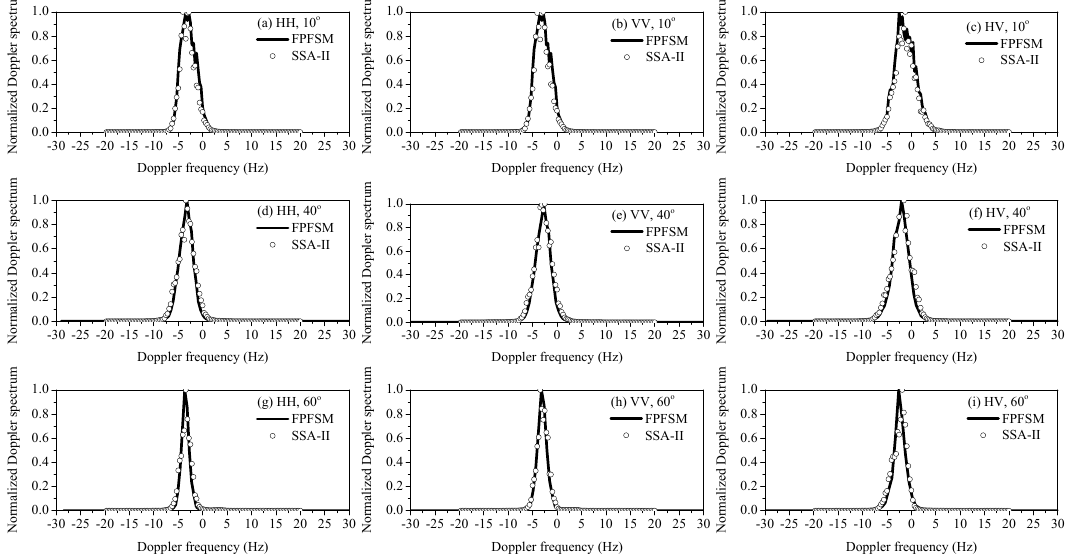
Figure 9. Comparison of Doppler spectrum results calculated by FPFSM and SSA-II at L-band for different incident angles and polarizations.